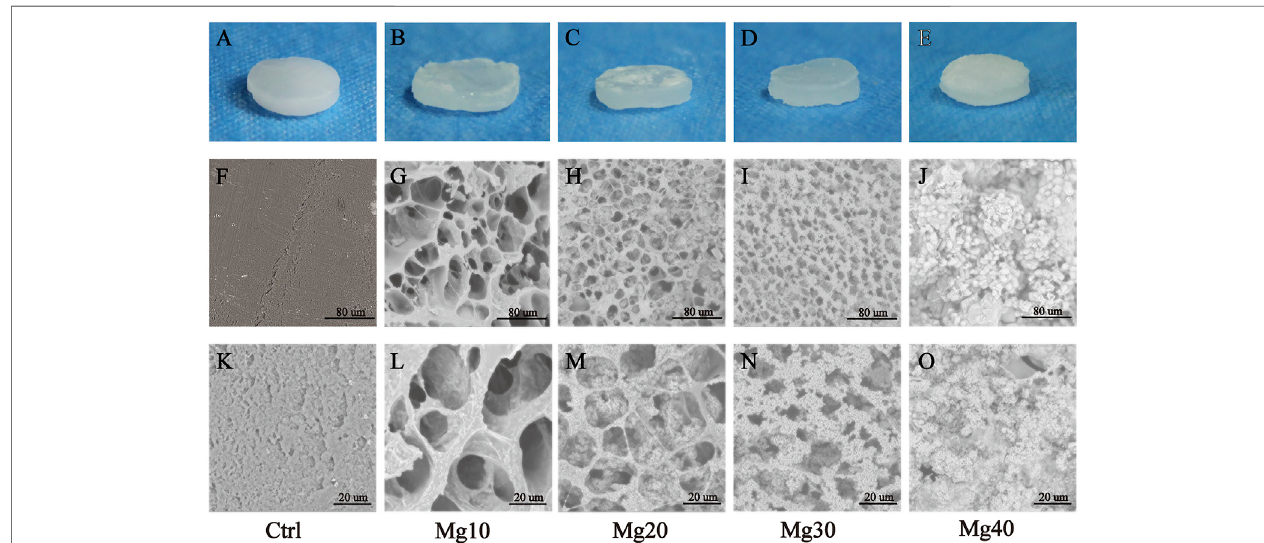
FIGURE 1 | (A – E) The appearance of MgSO 4 /MgO/SA/Na-CMC composite hydrogel dressings. SEM images of the internal structure of hydrogels with low (F – J) and high (K – O) magni fi